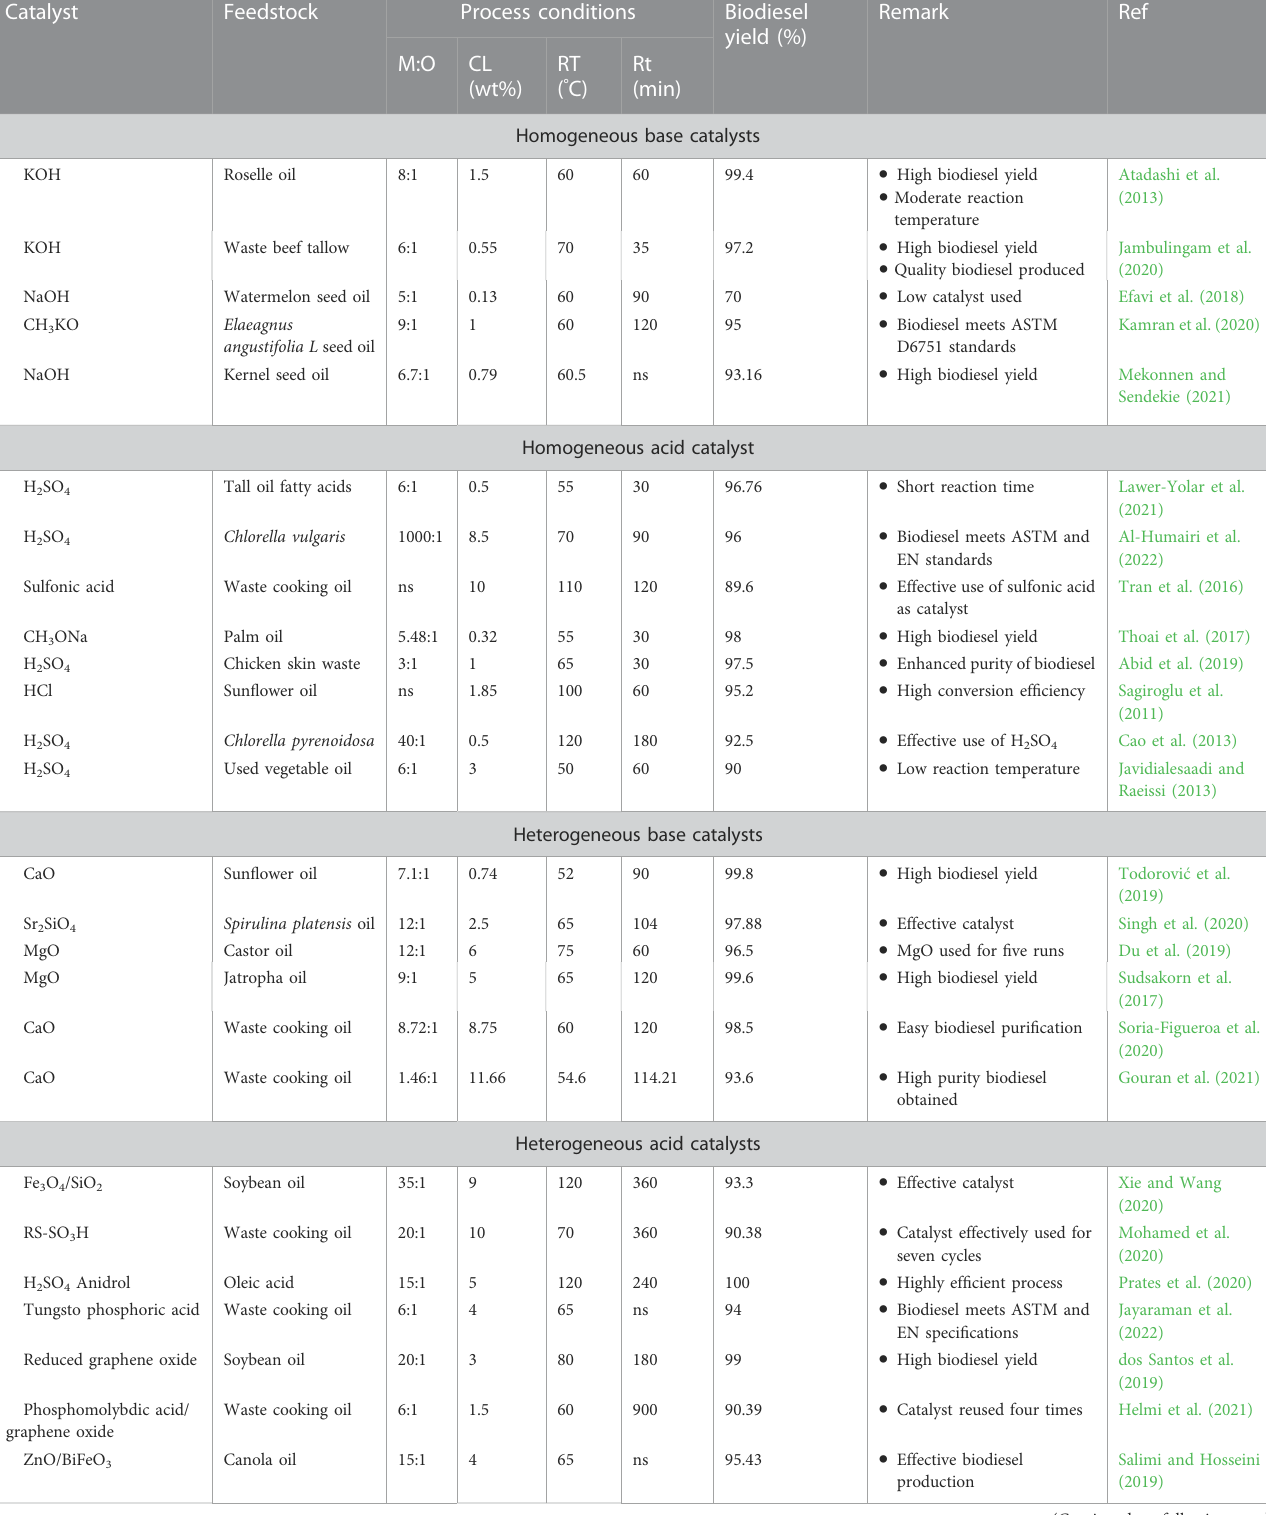
TABLE 3 Categories of catalysts used for biodiesel production.